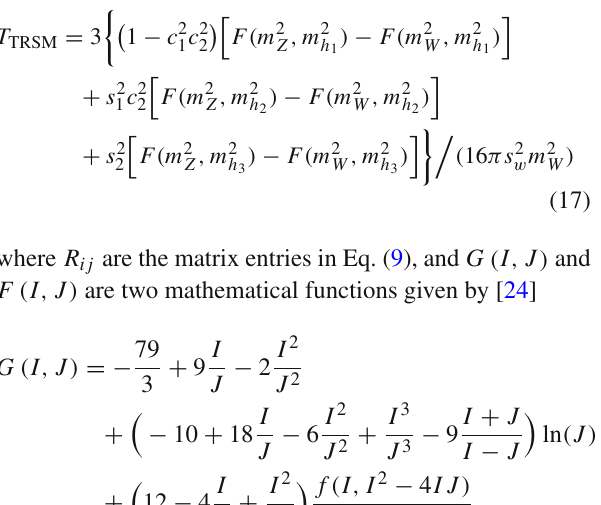
4 − 2 / L = 2, such that the overall quadratic divergences are picked out exclusively. The relevant contributions can